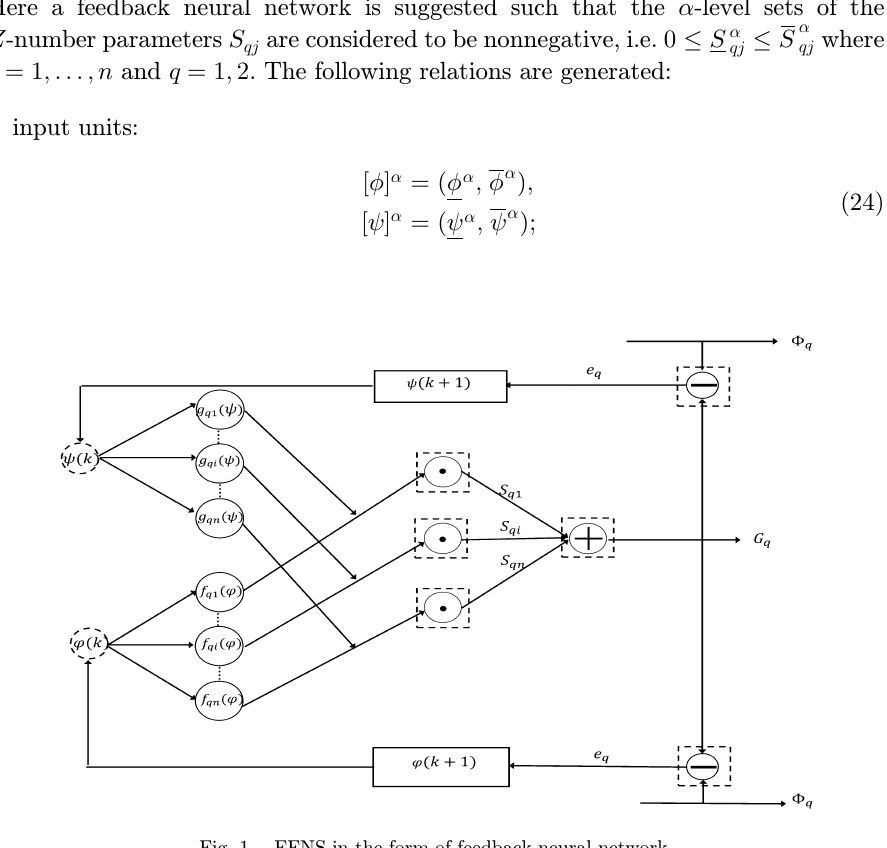
Fig. 1. FFNS in the form of feedback neural